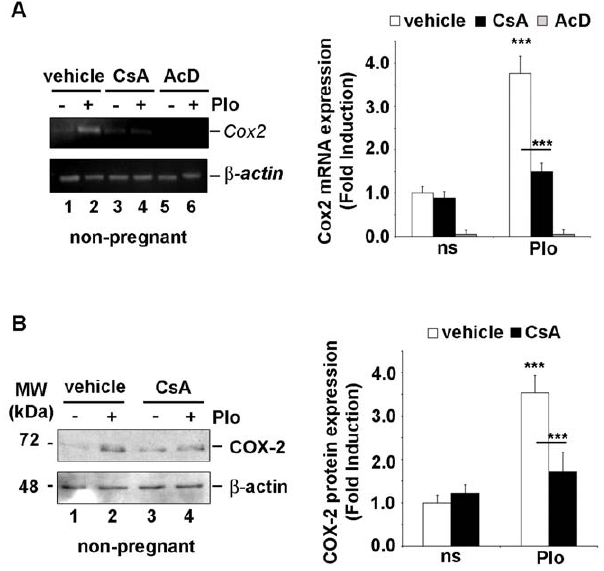
Figure 1. Calcium-induced expression of COX-2 was dependent on calcineurin activity in primary ESC of non-pregnant rats. Primary ESC were isolated from uteri of non-pregnant rats and cultured during 96 h. (A) Cox-2 mRNA was amplified from total RNA by semi- quantitative RT-PCR. The transcript of b -actin was used as internal control. Primary cells were pretreated for 1 h with vehicle (lanes 1–2), 200 ng/ml of CsA (lanes 3–4), or 10 m g/ml of actinomycin D (AcD, lanes 5–6), and then exposed to PIo (a combination of 20 ng/ml of PMA plus 1 m M calcium ionophore Io, for 4 h (lanes 2, 4, 6), or left untreated (lanes 1, 3, 5). (B) Immunoblots of whole extracts obtained from ESC showing endogenous protein expression of COX-2 and b -actin as a loading control. Cells were pretreated as before for 1 h with vehicle (lanes 1–2) or CsA (lanes 3–4) and then exposed to PIo, for 8 h (lanes 2–4). (A and B). Right panels bar plots show the densitometric data analysis of the results shown in the left panels A and B. The COX-2/ b -actin ratio was calculated and plotted against the values obtained with the control, non-stimulated rat ESC, which were assigned a value of 1 (ns). The values plotted are the means 6 SD of the fold induction values obtained from three independent experiments. Open bars, cells pre- treated with vehicle; closed black bars, cells pre-treated with CsA; closed gray bars, cells pre-treated with AcD. *** P , 0.001; ** P , 0.01